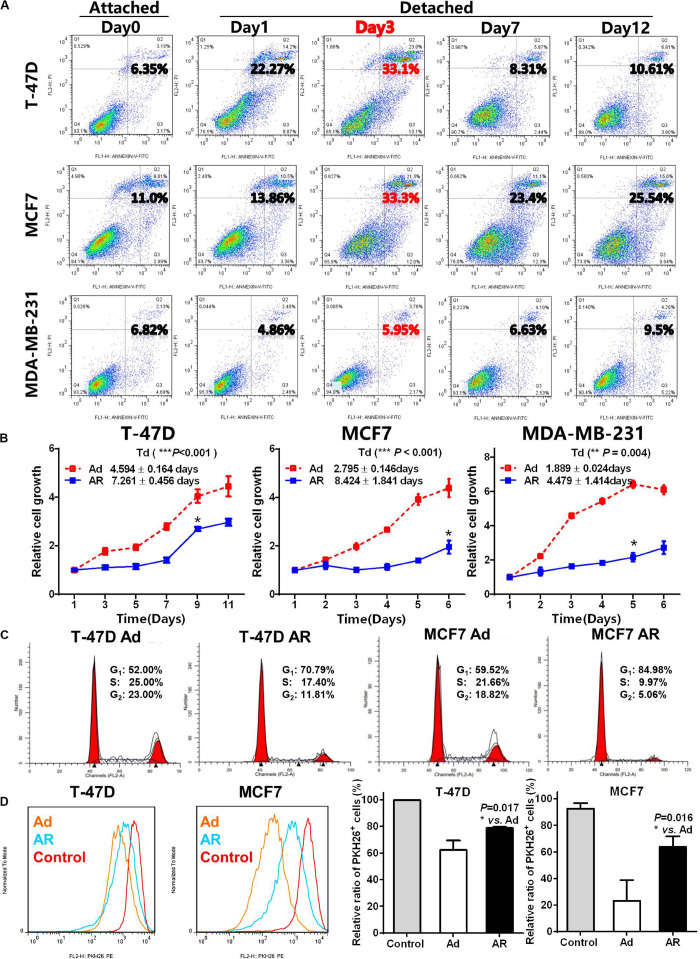
Detachment promotes CSC features of breast cancer cells. (A) Apoptosis analysis in breast cancer cells cultured under an attached condition in a common uncoated plate or a detached condition in ultra-low attachment plate for up to 12 days. (B) Cell growth measurement by detecting the WST-8 dye absorbance at 450 nm in breast cancer cells cultured under an adherent (Ad) or anoikis resistant (AR) condition for 7 days and then cultured under an adherent condition for up to 12 days. Td, doubling time. (C) Cell cycle distribution analysis in T-47D and MCF7 cells cultured under an Ad or AR condition for 7 days. (D) Cell proliferation analysis by PKH 26 staining in T-47D and MCF7 cells cultured under an Ad or AR condition for 7 days. Unlabeled cells were choosing as a control.